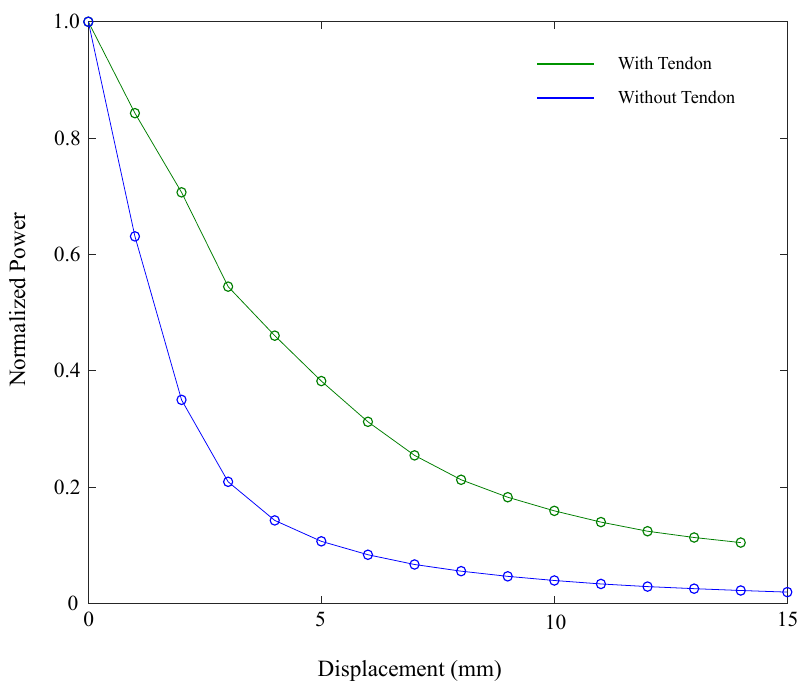
Figure 11. Comparison between isolated sensor response (blue) and response of sensor attached to the tendon